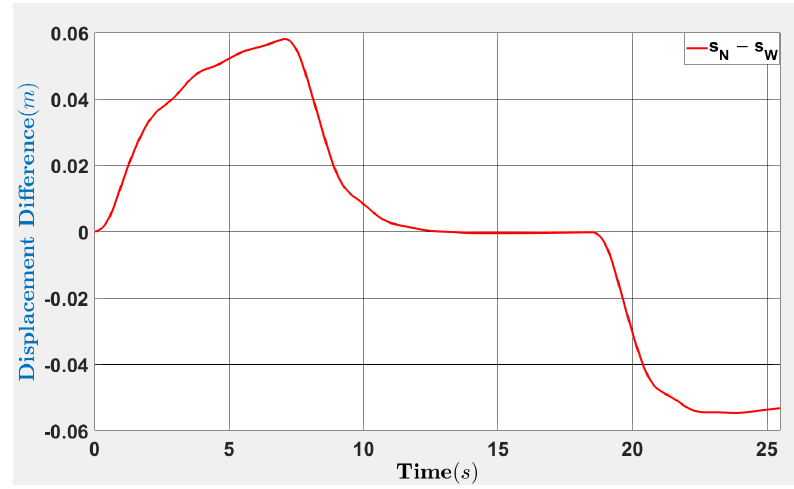
Figure 8. Dissimilar Displacements at Narrow and Wide Sides.